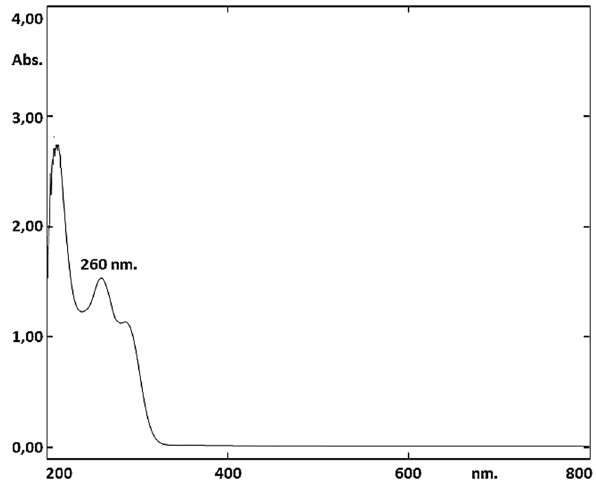
Figure 1: UV spectrum of ibrutinib standard solution ( 25 µg · mL − 1 )